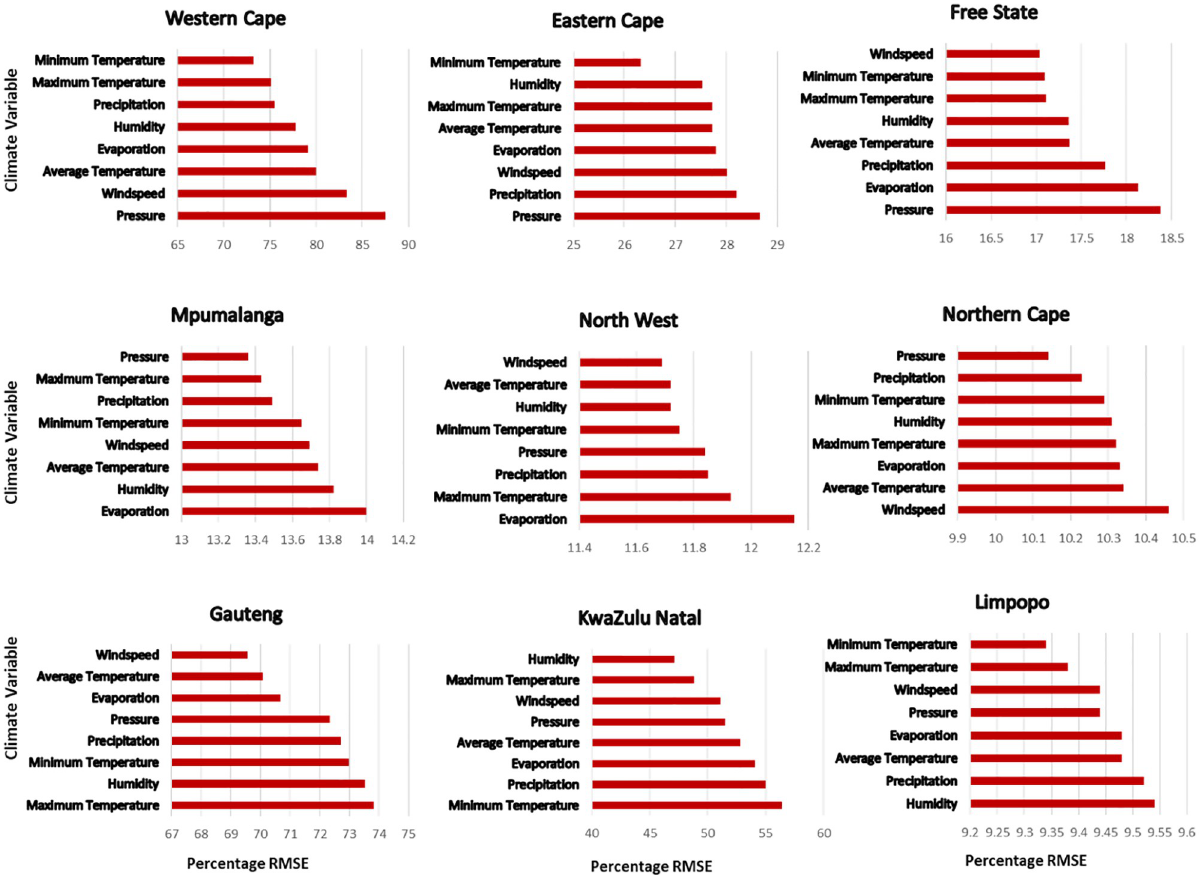
Fig 9. Variable importance plot. Result of the sensitivity analysis carried out for the CNN prediction method for each province. The x-axis indicates the prediction accuracy of the method once the variable on the y-axis is omitted from the method. The longer the bar, the larger the loss in accuracy and the higher the importance of that